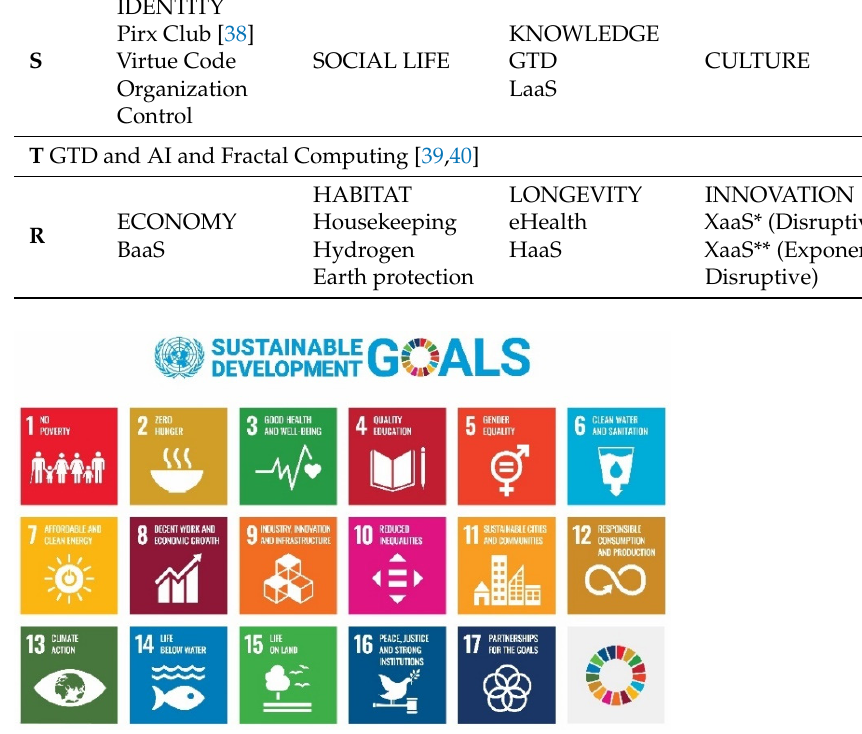
Table 1. Illustrating the example virtue code and associated failures.